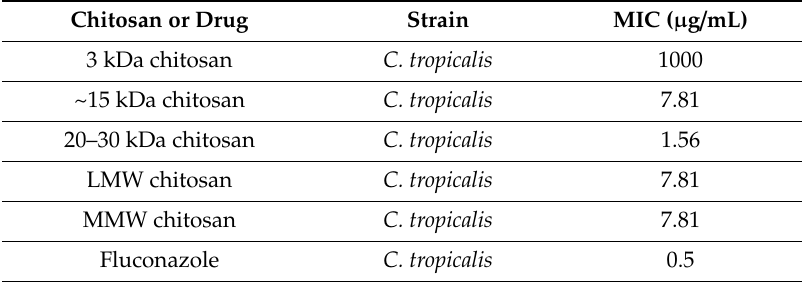
Table 3. MICs of chitosans of di ff erent MWs and degrees of deacetylation in combination with fluconazole against C. tropicalis MYA3404.